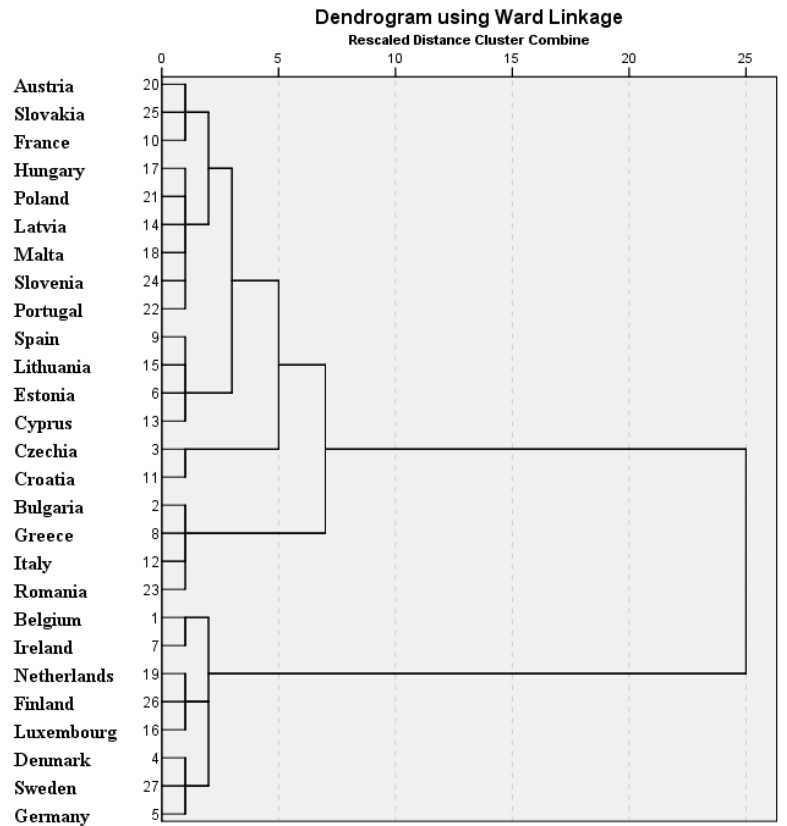
Figure 1. Cluster generation dendrogram corresponding to 2012.